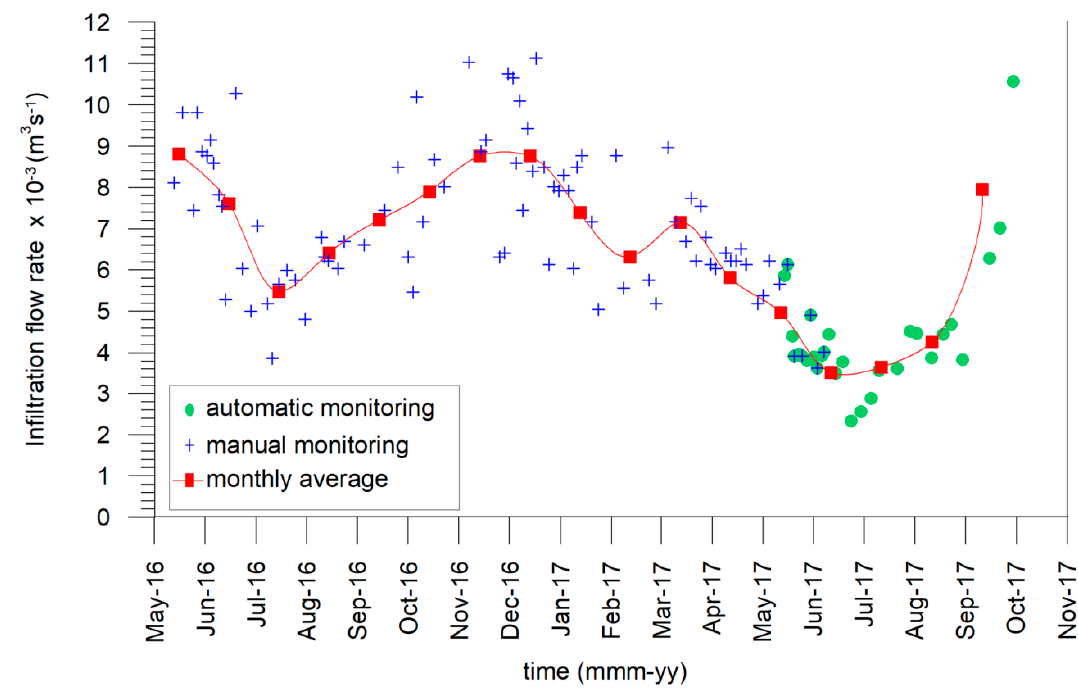
Figure 3. Infiltration flow rate vs. time observed over 18 months for Trench 9. Manual monitoring was performed once per day, while in the automatic monitoring system a measurement was collected every 10 min.